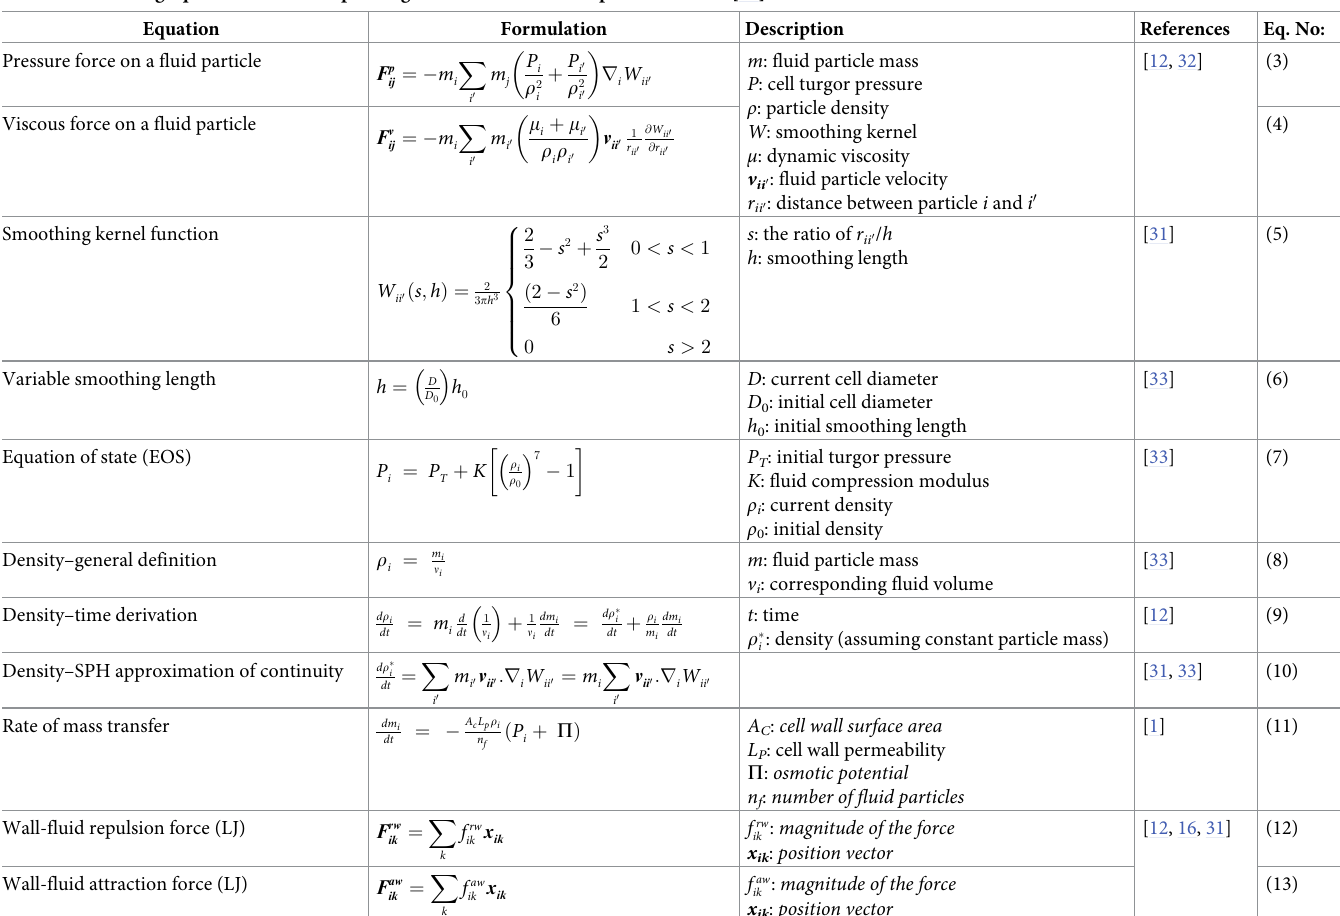
Table 1. Governing equations and corresponding formulae for the fluid particle scheme [18]. Equation Formulation Description Eq.